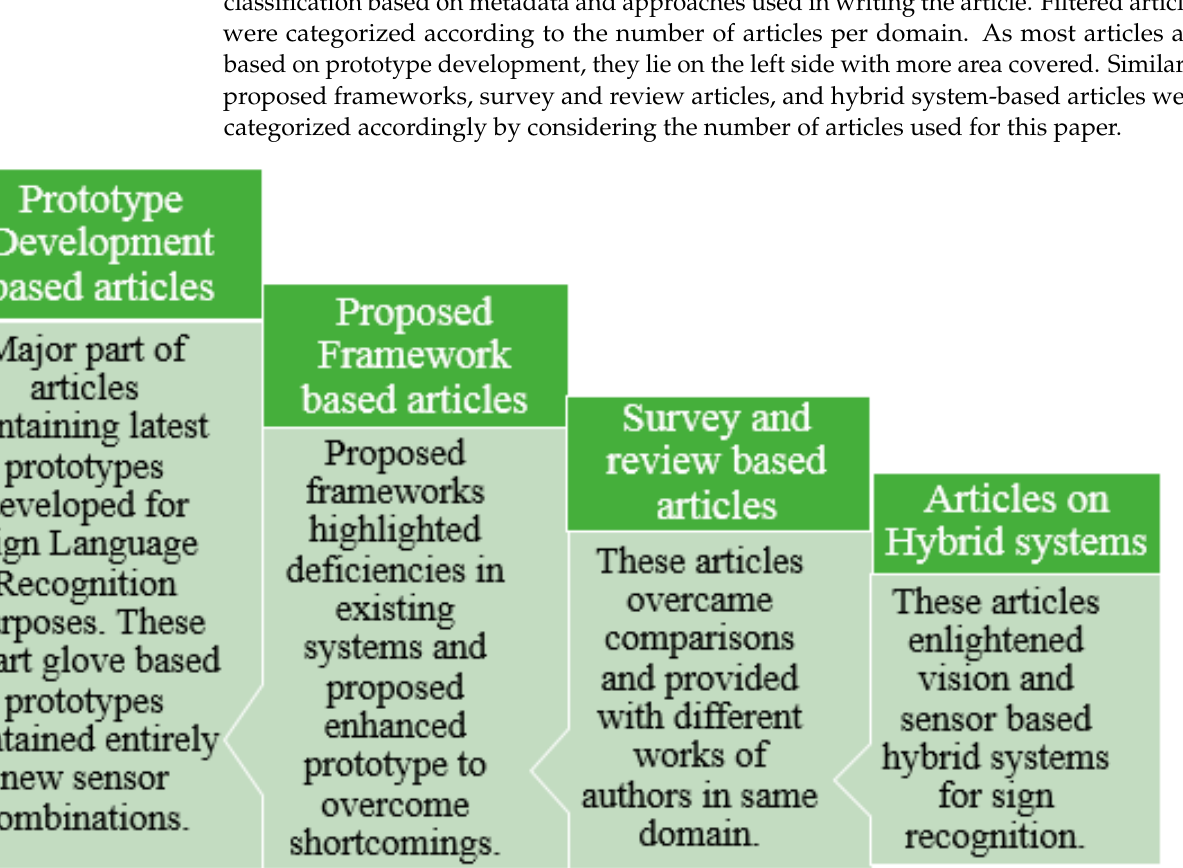
Figure 14. Categorical division of filtered articles used in this paper.